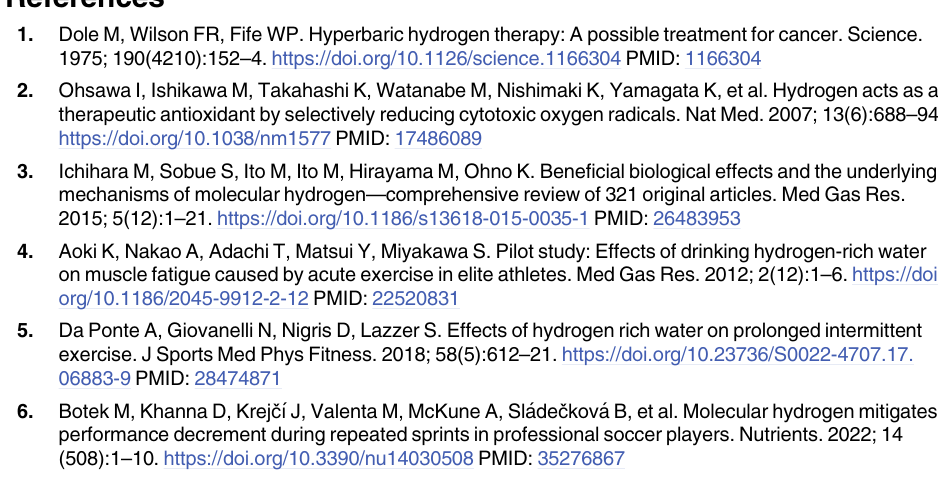
S1 Table. Raw data for Table 1. S2 Table. Raw data for Table 3, part 1. S3 Table. Raw data for Table 3, part